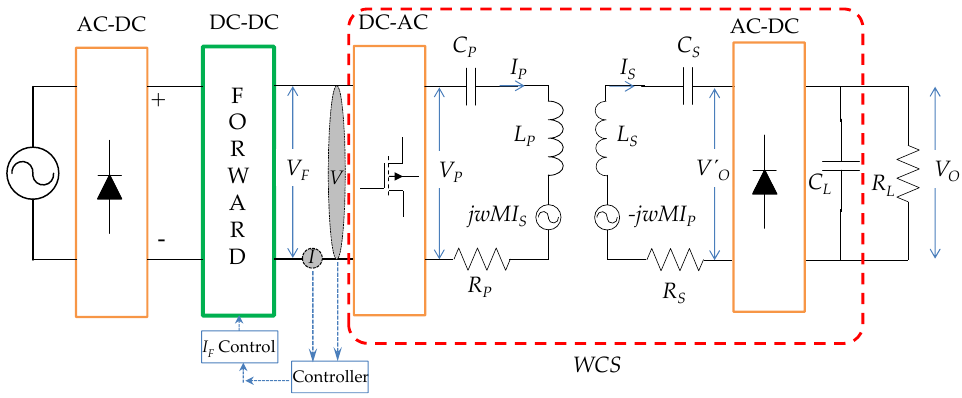
Figure 2. Structural diagram of the IPT proposed for e ‐ bike wireless charging.